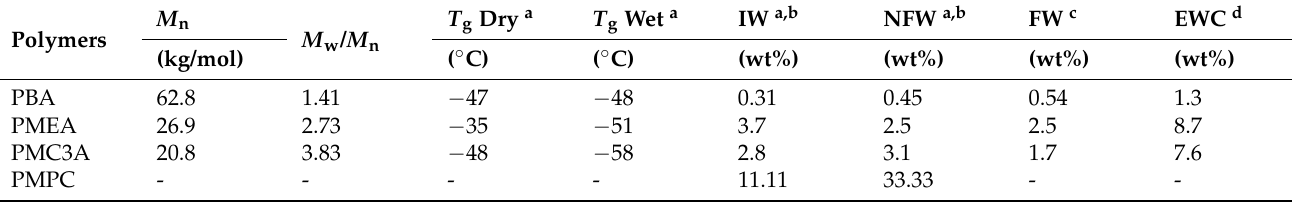
Figure 1. Chemical structure of ( A ) polyethylene terephthalate (PET); ( B ) poly( n -butyl acrylate) (PBA); ( C ) poly(2-methoxyethyl acrylate) (PMEA); ( D ) poly(3-methoxypropyl acrylate) (PMC3A), and ( E ) poly( n -butyl methacrylate 70 - co -2-methacryloyloxyethyl phosphorylcholine 30 ) (PMPC). Table 1. Characterization of PMEA-analogous polymers.